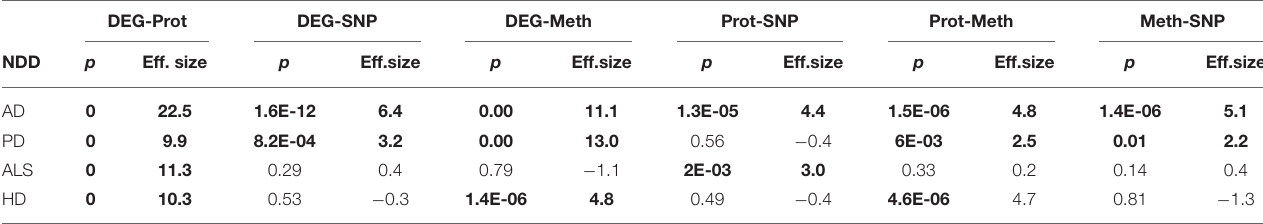
The results show that the number of significantly striking genes that emerged in transcriptomic and proteomic data was significantly high in all four analyzed diseases. The number of genes intheother pairwiseintersections wasonly significantly highintwo tothreeoftheanalyzed diseases. AD,theNDDwiththelargest database inourstudy, showed significantly high numbers of genes in all pairwise intersections. Additionally, the effect sizes of these hypergeometric test results are depicted as explained in Equation (2). Especially, the intersections between transcriptomic and proteomic layers show large effect sizes in all groups. Cells associated with significant overlaps are depicted in bold letters. SNP, genomic level; DEG, transcriptomic level; Prot, proteomic level; Meth, methylomic level.